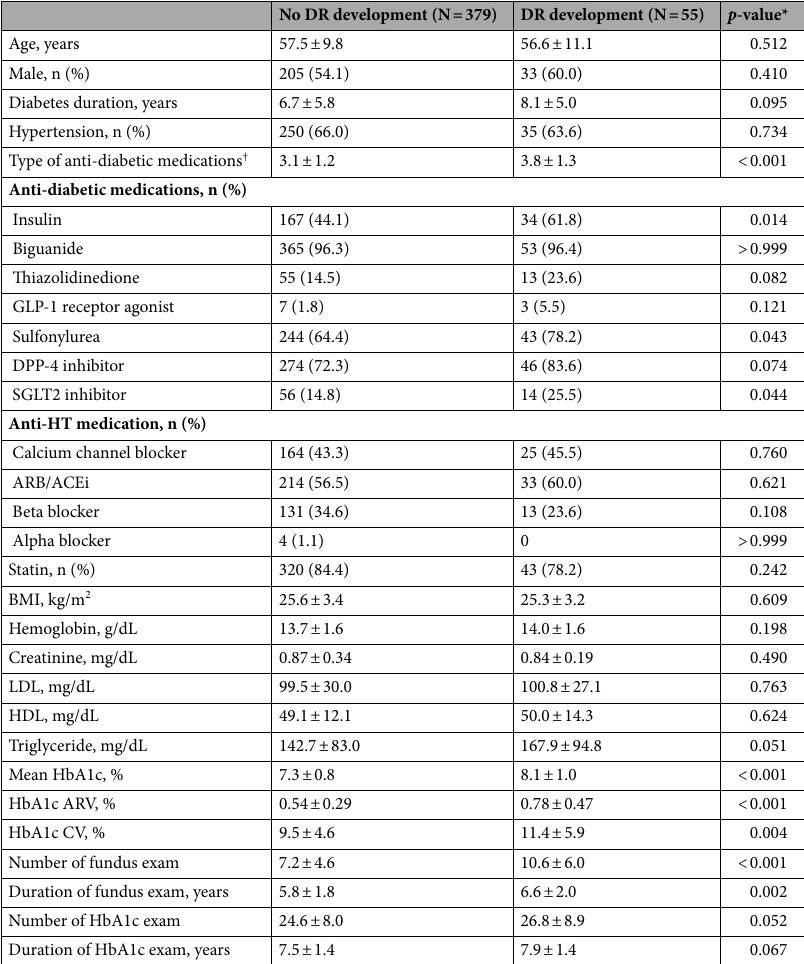
Table 1. Demographics and clinical characteristics of the subjects classified according to the development of diabetic retinopathy during follow-up. *Student’s t -test for continuous variables and chi-square test for categorical variables. Abbreviations: Anti-HT, anti-hypertensive; ARB/ACEi, angiotensin receptor blocker/ angiotensin-converting enzyme inhibitor; ARV, average real variability; BMI, body mass index; CV, coefficient of variation; DPP4, dipeptidyl peptidase-4; DR, diabetic retinopathy; GLP-1, glucagon-like peptide-1; HbA1c, hemoglobin A1c; HDL, high-density lipoprotein; LDL, low-density lipoprotein; SGLT2,